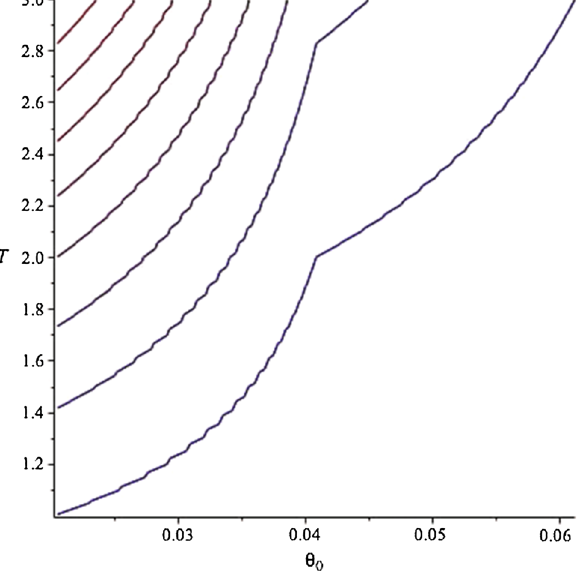
Fig. 2 Figures show contour plots of T = constant in P as functions of θ 0 . Different lines in each graph show a specific temperature